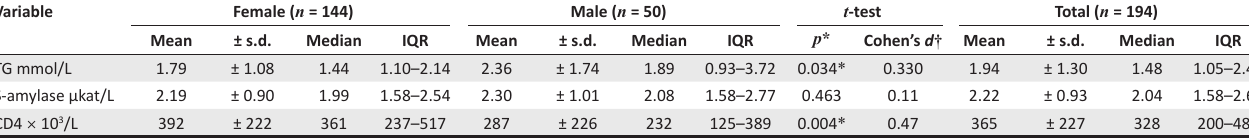
TABLE 2: Results of plasma variables at six months post lopinavir/ritonavir initiation. Variable